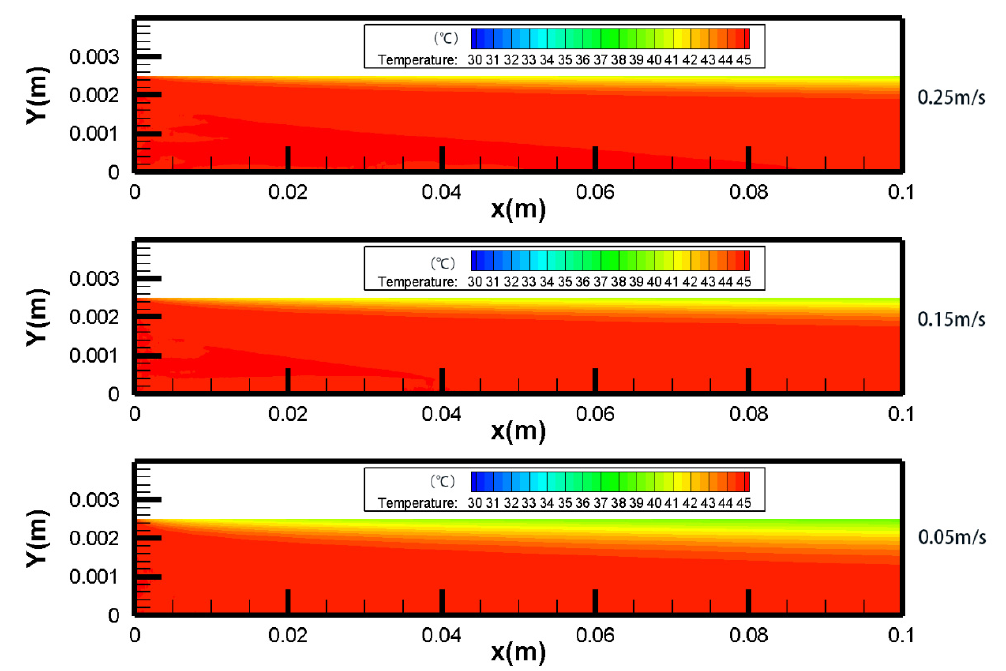
Figure 5. Temperature polarization coe ffi cient in di ff erent T f ( v f , v p = 0.15 m / s, T p = 25 ◦ C, c f = 24.2 wt.%).